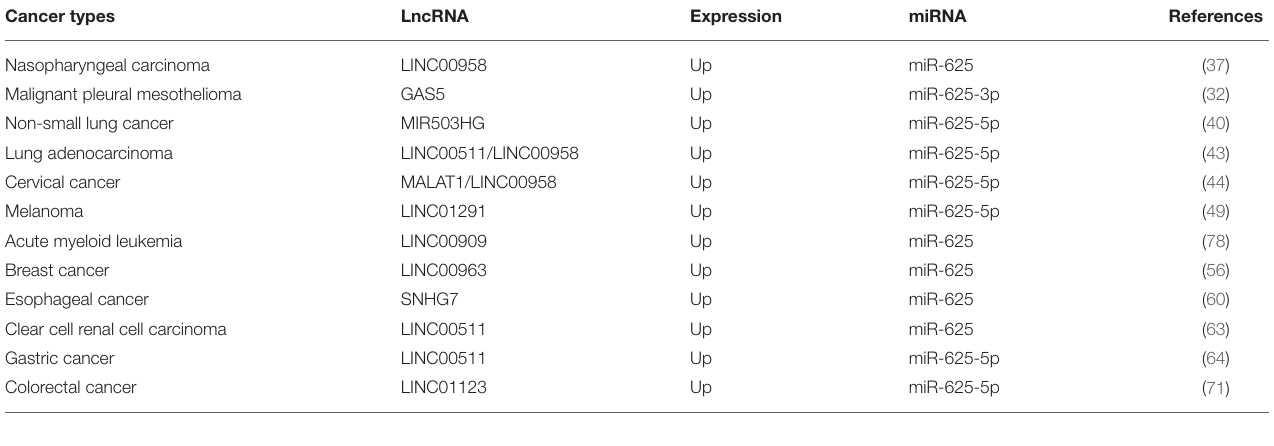
TABLE 3 | Summarization of lncRNA-miR-625 in human cancers.